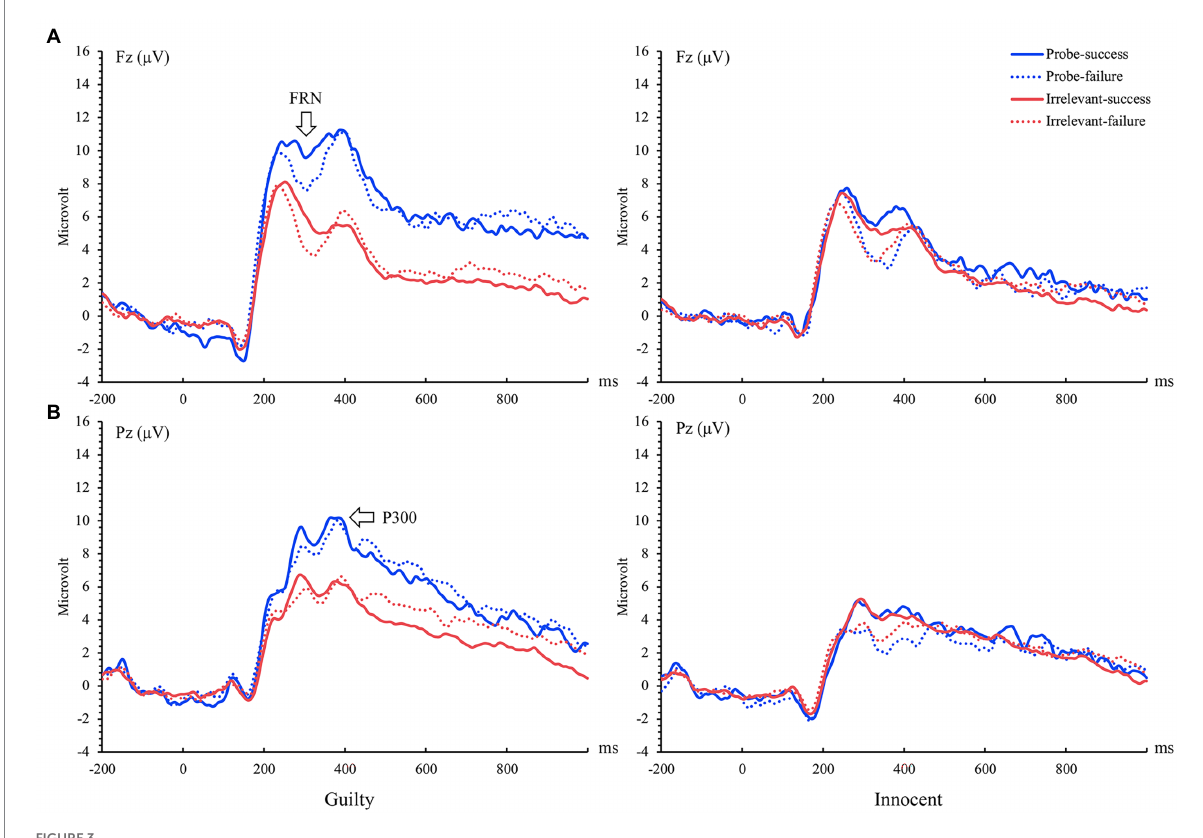
FIGURE 3 Grand-average ERP waveforms before principal component analysis (PCA) transformation of feedback related negativity (FRN) (A) and feedback-P300 (B) induced by guilty and innocent in the feedback